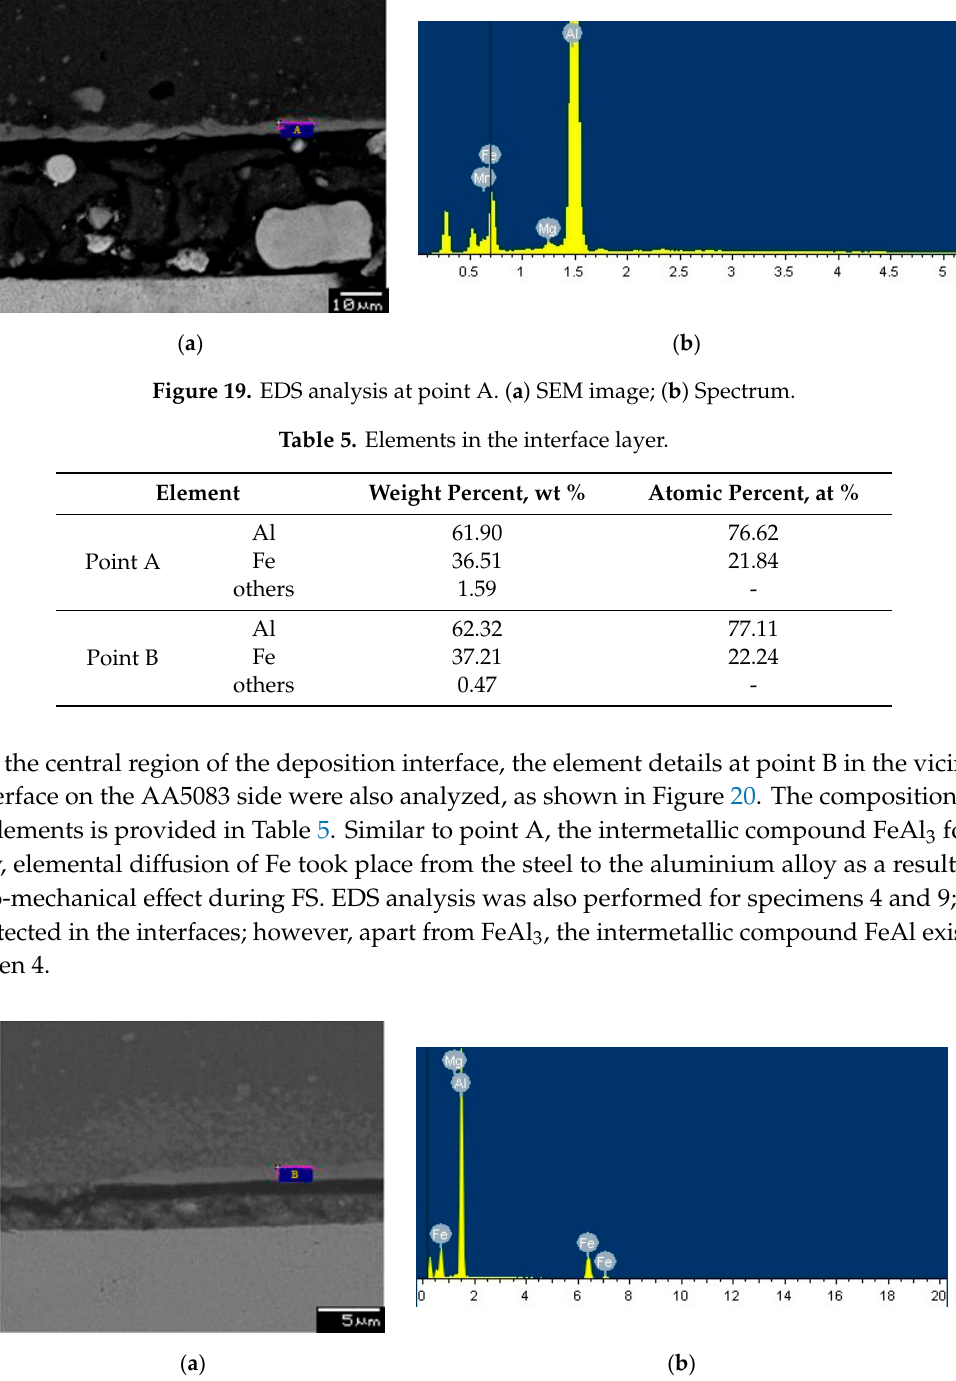
( b ) Figure 21. Bending test for sample 3: ( a ) sample; ( b ) force-displacement curve.